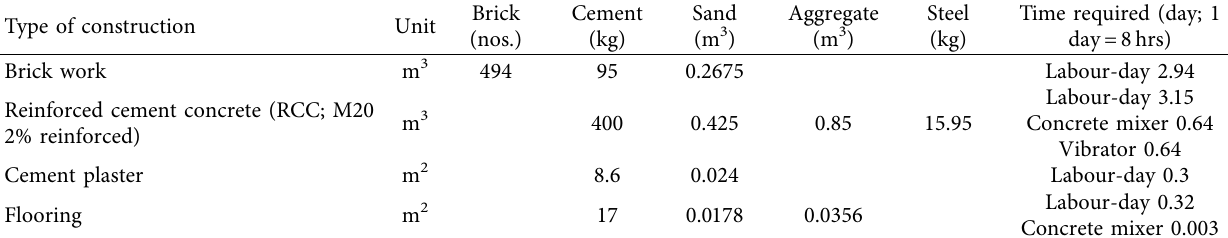
Table 2: Indian building construction details